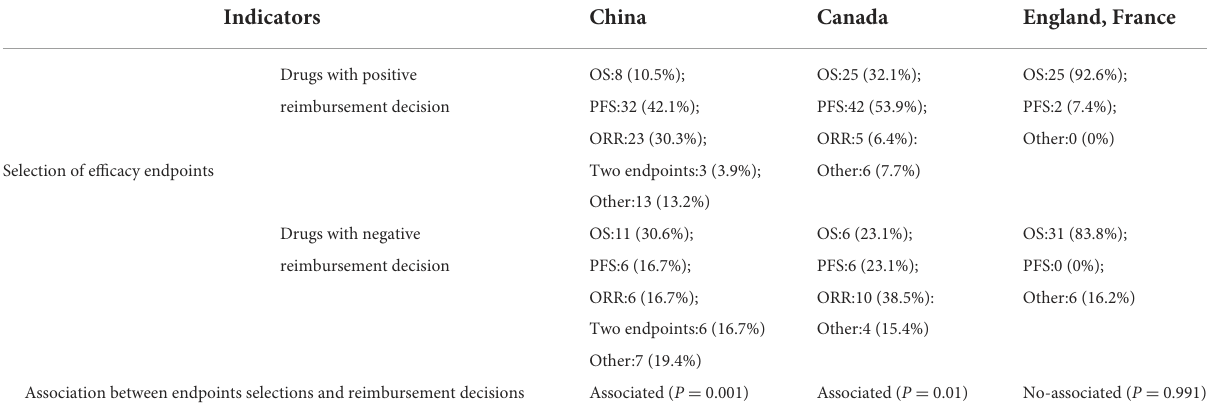
TABLE 4 Study results of different nations.